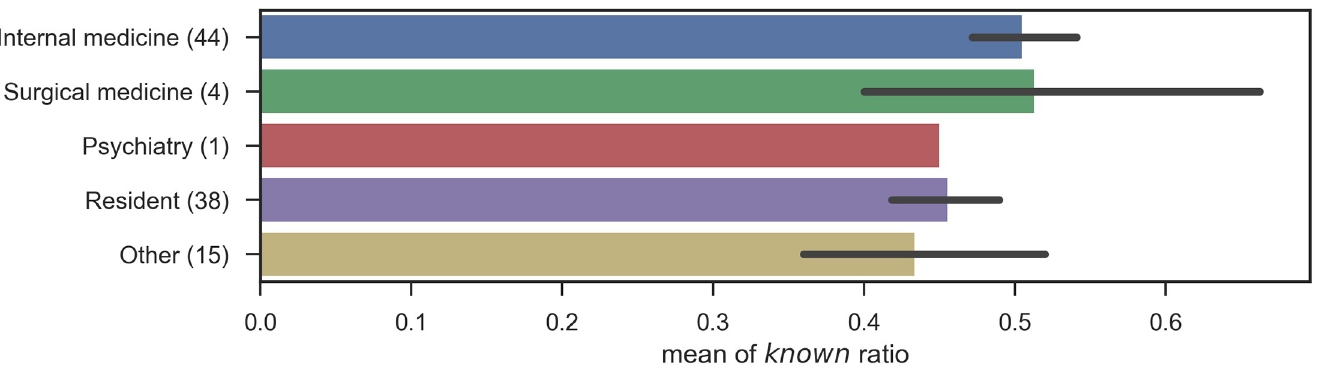
Fig 6. Known ratio, grouped by specialty category: The error bars shows the standard errors. The bar without error bar contains only one data.